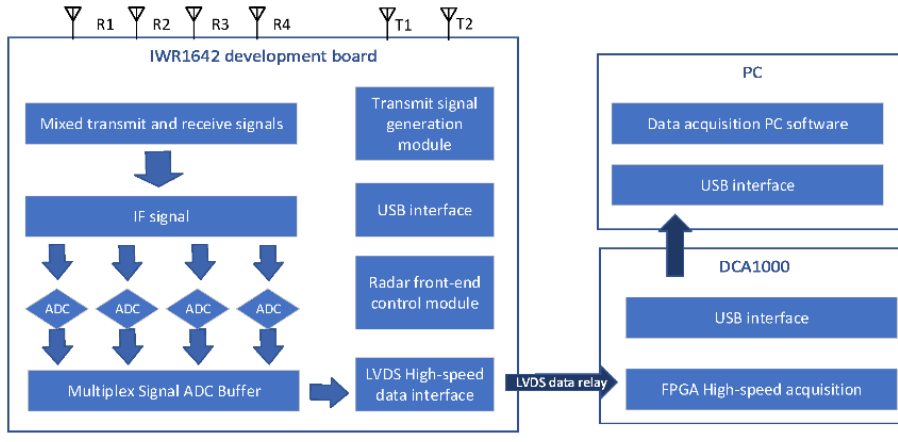
Figure 2. FMCW radar system.